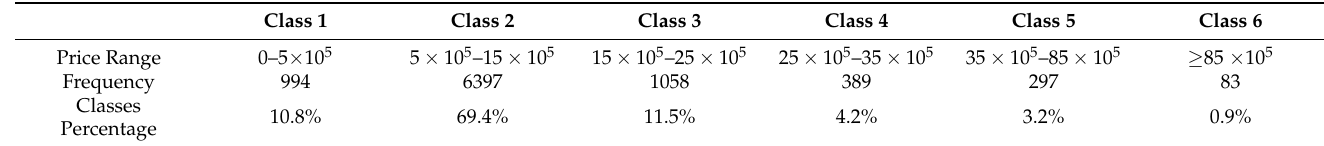
Table 1. Ranges and distributions of house price